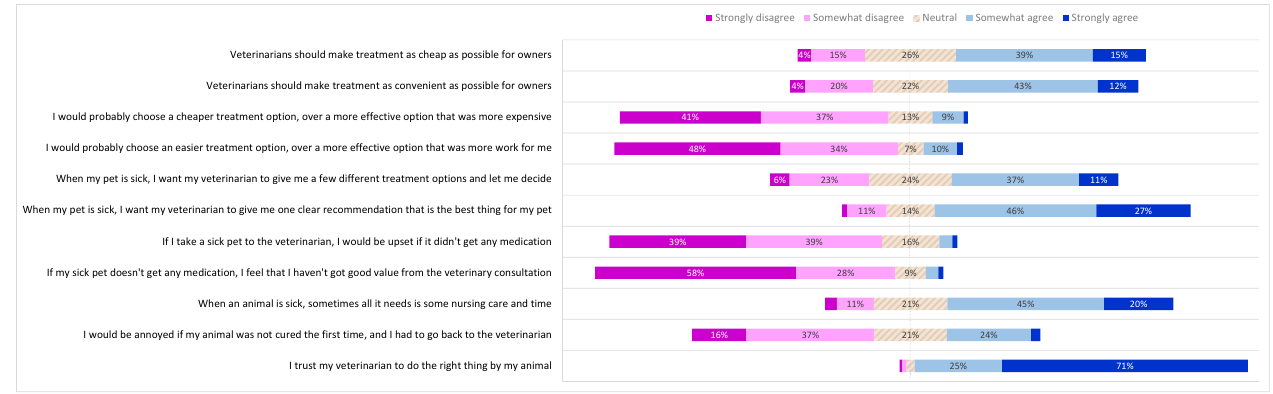
Figure 6. Pet owner expectations of the veterinary consultation, treatment preferences and trust. Pet owners were asked to what extent they agreed with each statement on the left. Proportions of responses to each statement corresponding to each of the five points of the Likert scale are shown. Data labels omitted where value is